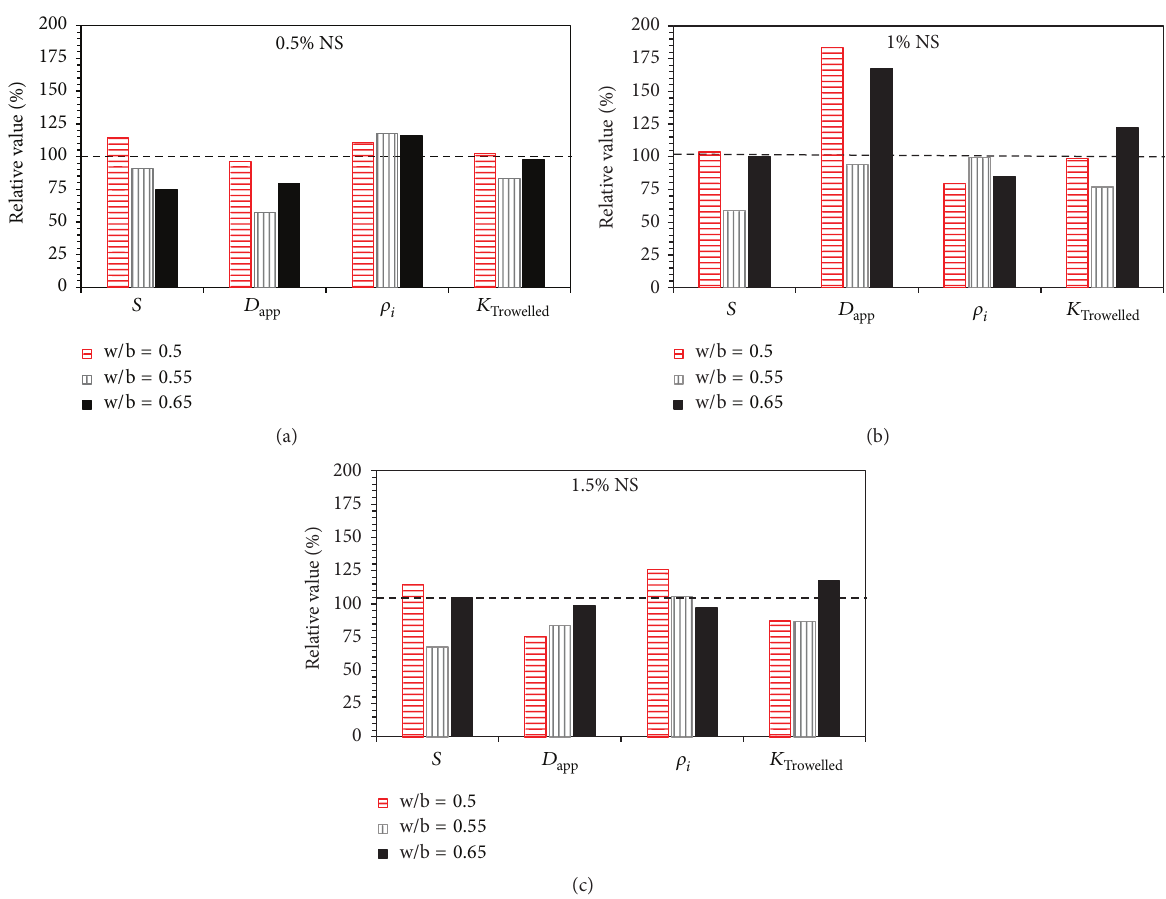
Figure 14: Effect of NS addition on concrete with different w/b; expressed as relative value of each parameter with respect to reference: (a) 0.5% NS addition, (b) 1% NS addition, and (c) 1.5% NS